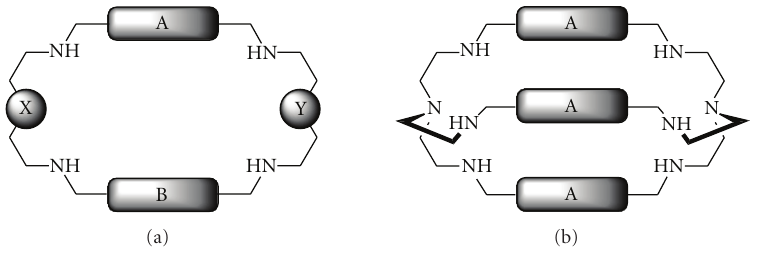
Figure 2: General representation of CBI (a) and CTI (b) macrocycles studied in this work. A, B: (hetero)aromatic residues; X, Y: O, NH, S, or pendant side